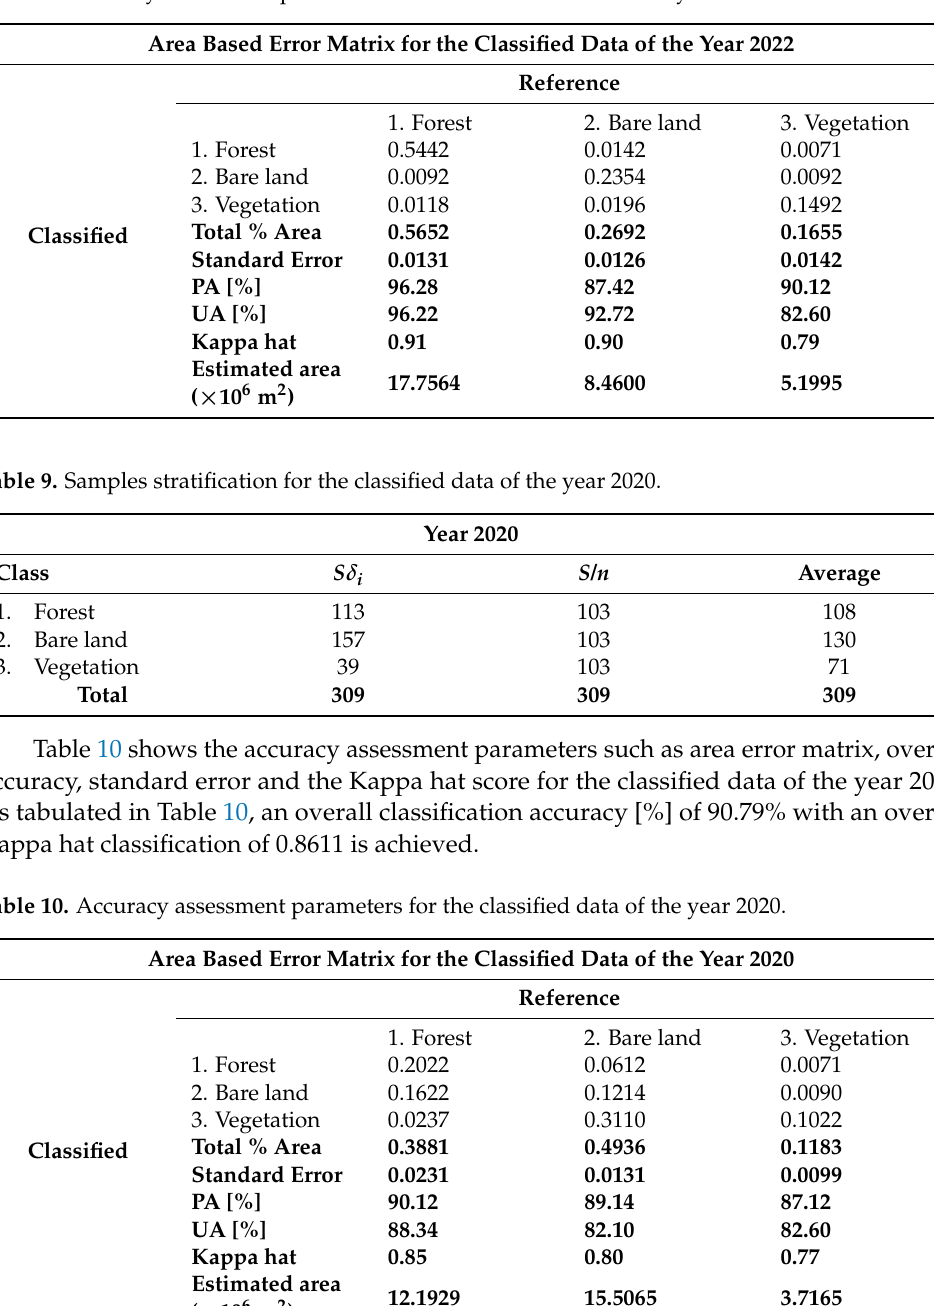
Table 8. Accuracy assessment parameters for the classified data of the year 2022.